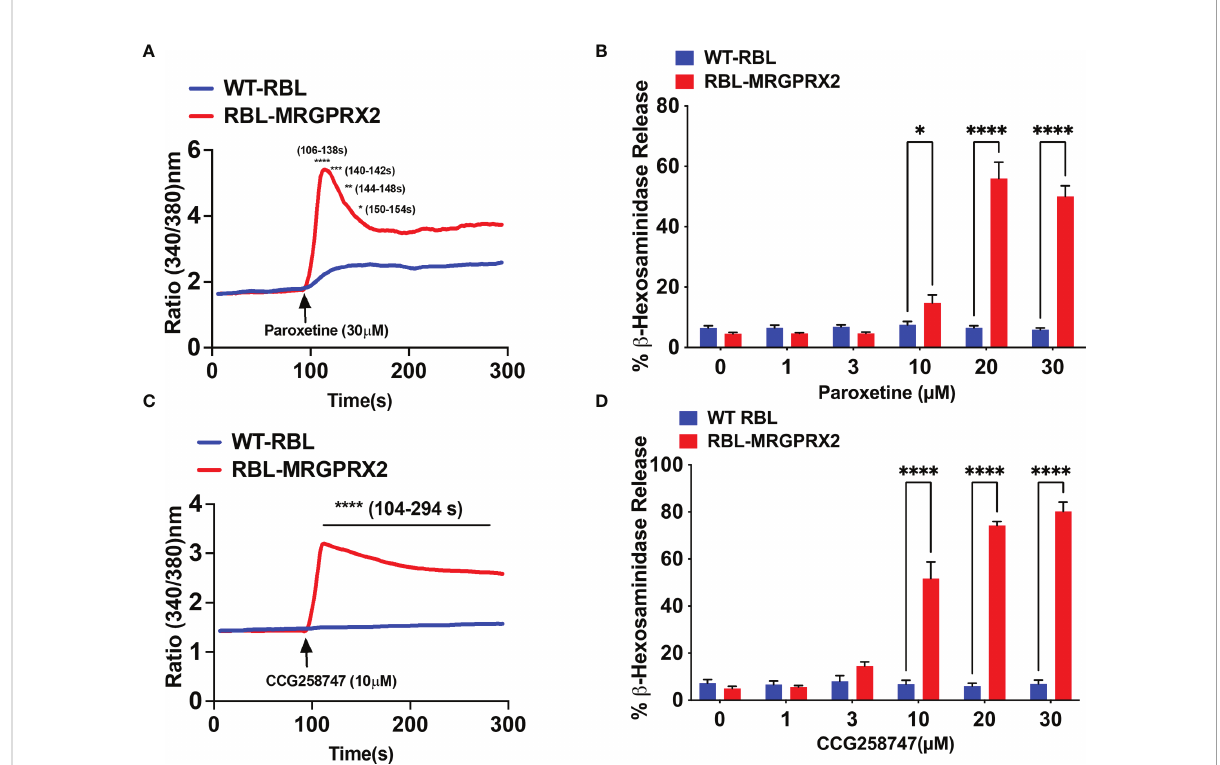
FIGURE 3 Paroxetine and CCG258747 induces intracellular calcium mobilization and degranulation via MRGPRX2. Untransfected RBL-2H3 (WT-RBL) and RBL-stably expressing MRGPRX2 (RBL-MRGPRX2) were exposed to paroxetine and (A) calcium mobilization (30 µM) and (B) b -hexosaminidase release (0 - 30 µM) were measured. Likewise, CCG258747-induced (C) calcium mobilization (10 µM) and (D) b -hexosaminidase release (0 - 30 µM) was measured. Error bars are standard error of mean (SEM) from three independent experiments and signi fi cant differences were set at *p ≤ 0.05, **p ≤ 0.01, ***p ≤ 0.001 and ****p ≤ 0.0001. Error bars are not displayed for A and C for